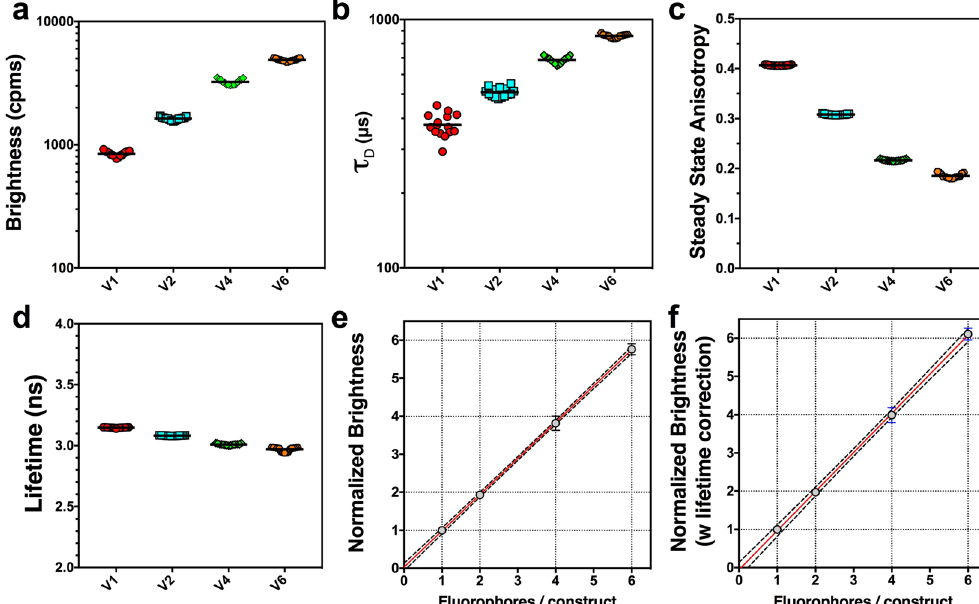
Figure 5. Auto-FPFA can detect structural changes caused by concatemerization. Auto-FPFA was used to characterize and compare Venus monomers (V1, red circles), Venus dimers (V2/V5V, blue squares), Venus tetramers (V4, green diamonds), and Venus hexamers (V6, orange hexagon). Auto-FPFA measurements of molecular brightness ( a ), diffusion time ( τ D , b ), steady state anisotropy ( c ), and lifetime ( d ) of the Venus multimers. Each sample consisted of 5 replicates of 3 different cell homogenates, and black bar is the mean value. The relationship between normalized brightness ( e ) or fluorescence lifetime corrected normalized brightness ( f ) is plotted as a function of the number of Venus fluorophores in each construct. Each point is mean ± SD (n = 15). Red line represents a linear fit through the data, and dashed blue lines are the 95% confidence